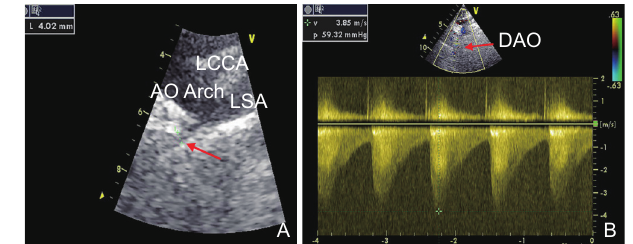
Figure 6 (A) Suprasternal view showing focal narrowing of the aorta distal to the left subclavian artery (red arrow). (B) Suprasternal view with continuous wave Doppler showing accelerated blood flow of narrowed aorta (peak velocity =3.85 m/s).